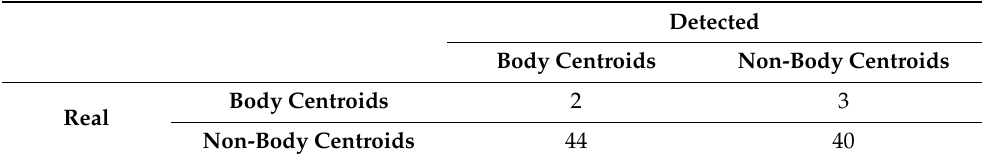
Table 8. The confusion matrix of real and detected body centroids using the maximum entropy